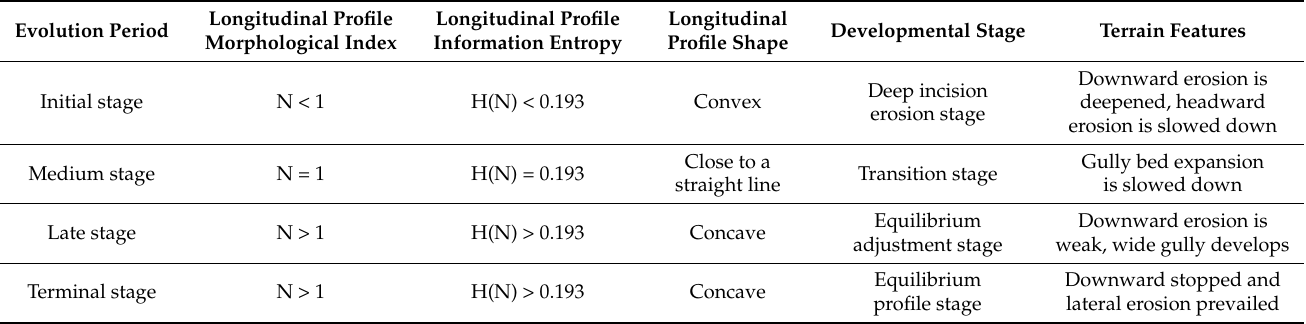
Table 1. Quantitative indices of the gully erosion development